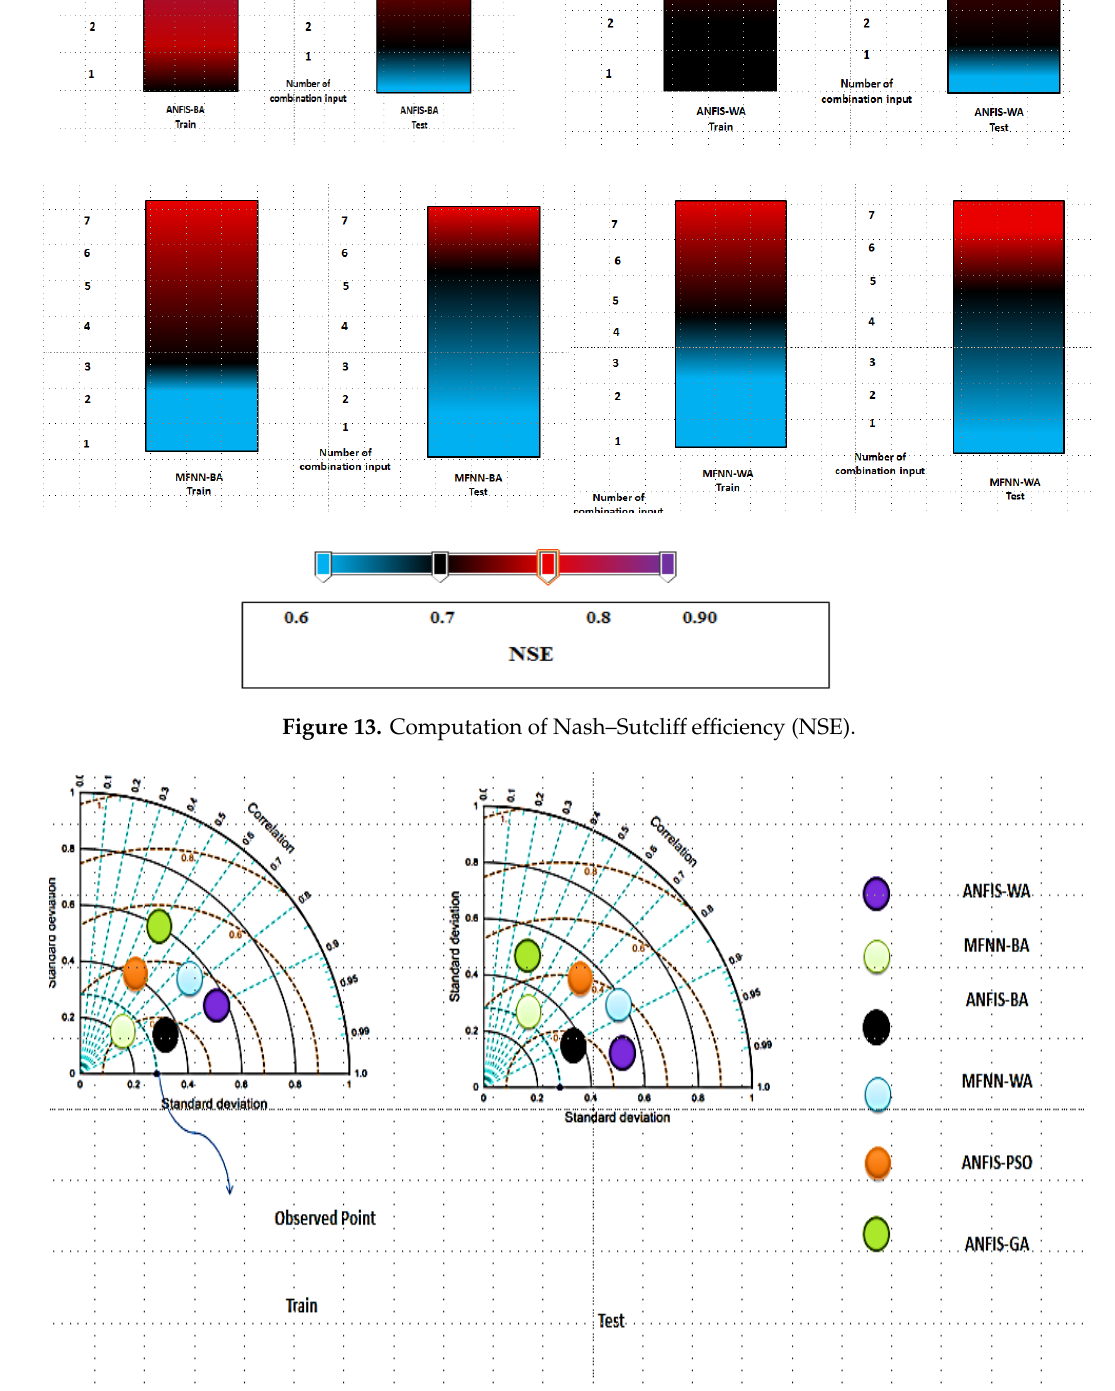
Figure 14. Taylor diagram for the different models.